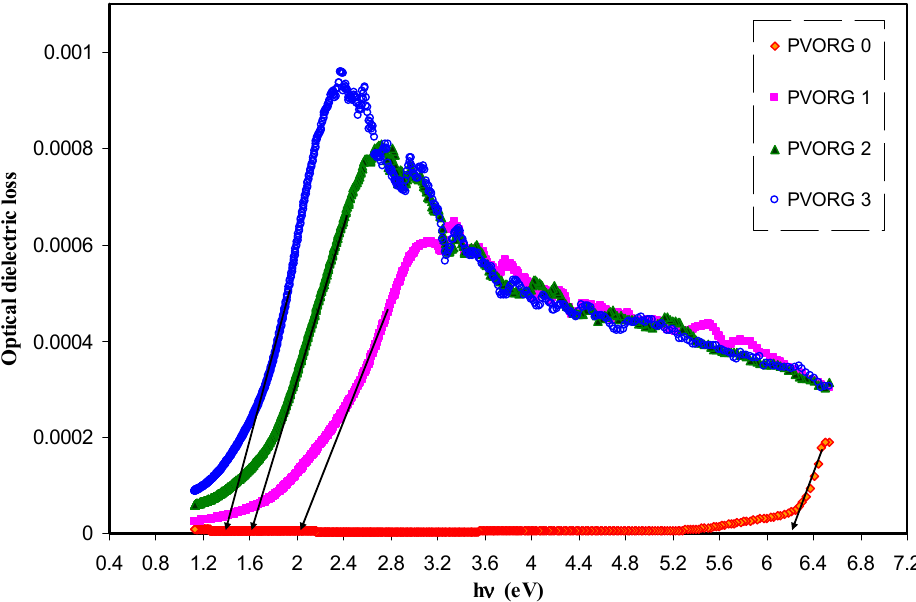
Figure 12. Dielectric loss spectra versus photon energy for pure PVA (PVORG0) and PVA composite films.